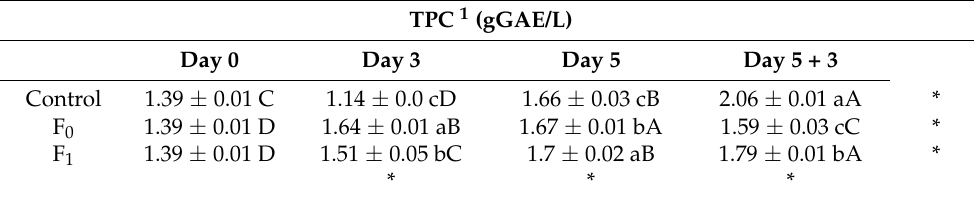
Table 8. TPC per treatments/each analysis